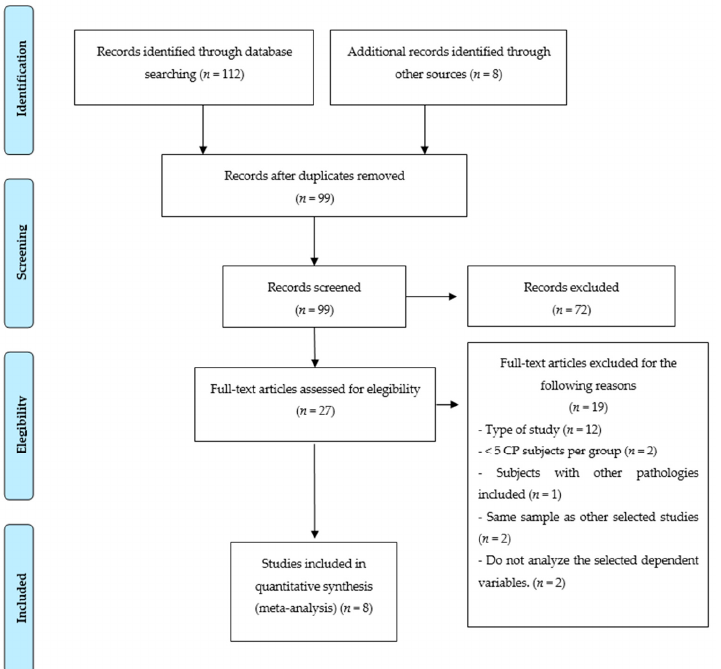
Figure 1. PRISMA flowchart of assessed